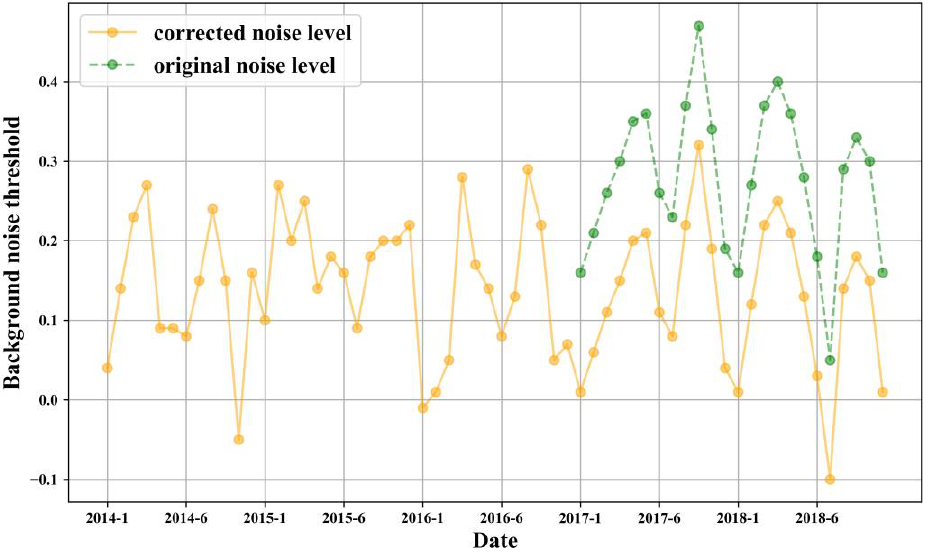
Figure 5. Selected threshold to distinguish background noise and human activity (HA).